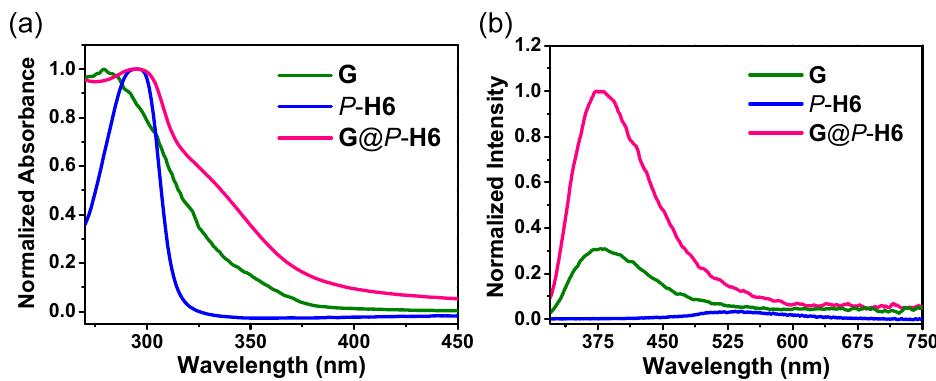
Figure 6. ( a ) Absorption and ( b ) photoluminescence spectra of G , P - H6 , and G @ P - H6 in solid state at 300 K ( λ ex = 290 nm).